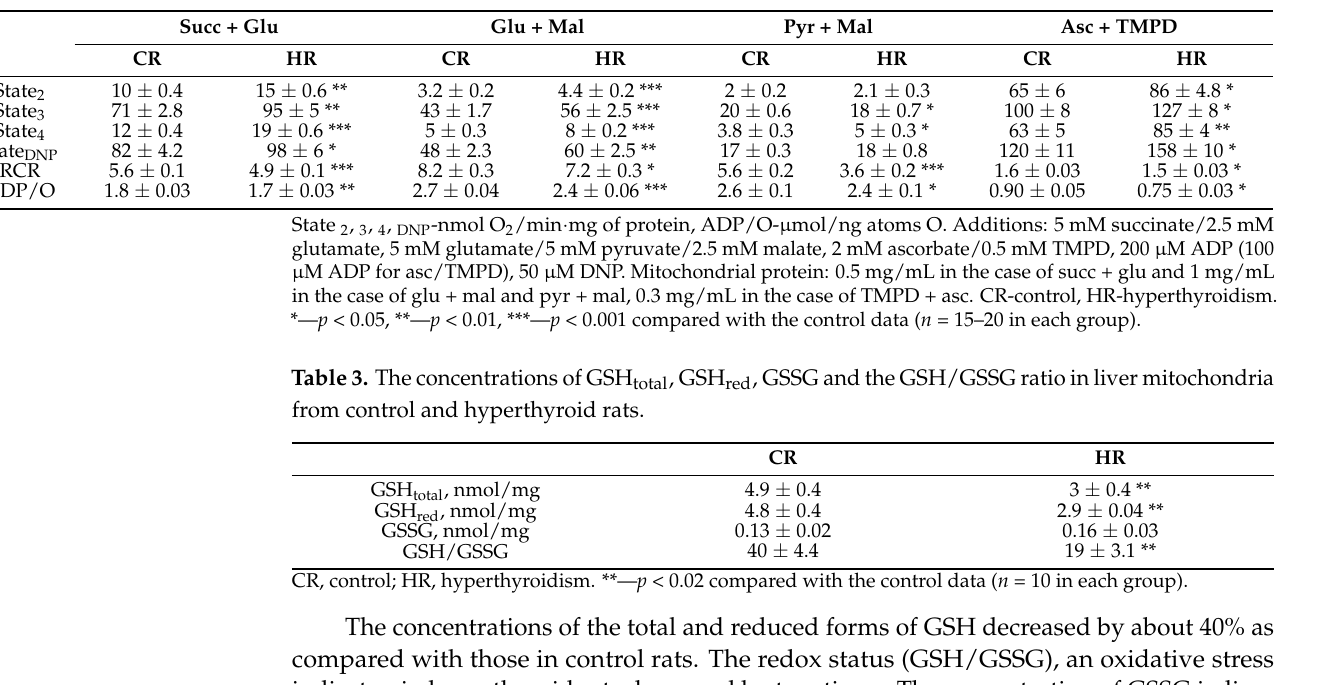
Table 2. The parameters of respiration and oxidative phosphorylation of liver mitochondria of control and hyperthyroid rats.